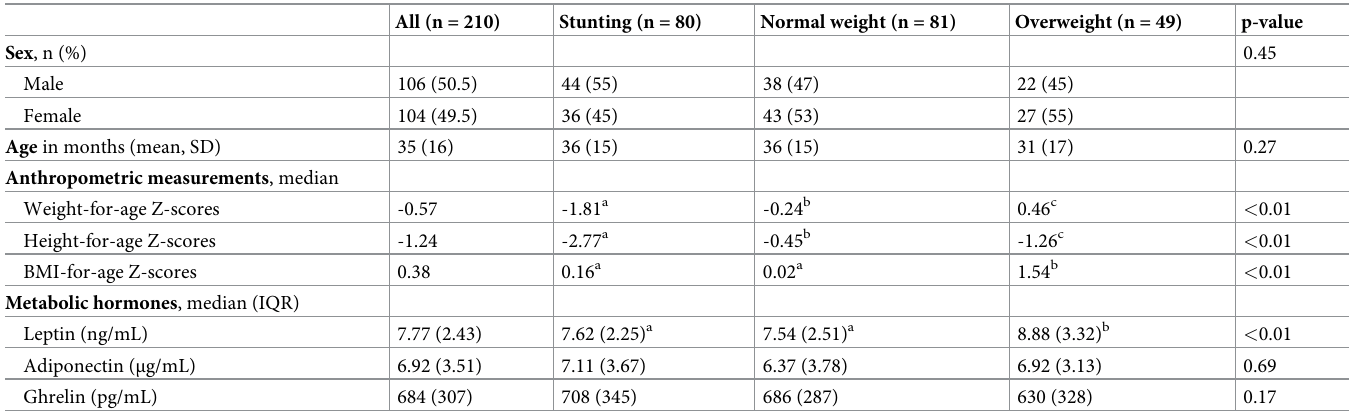
Table 1. Baseline characteristics of the study